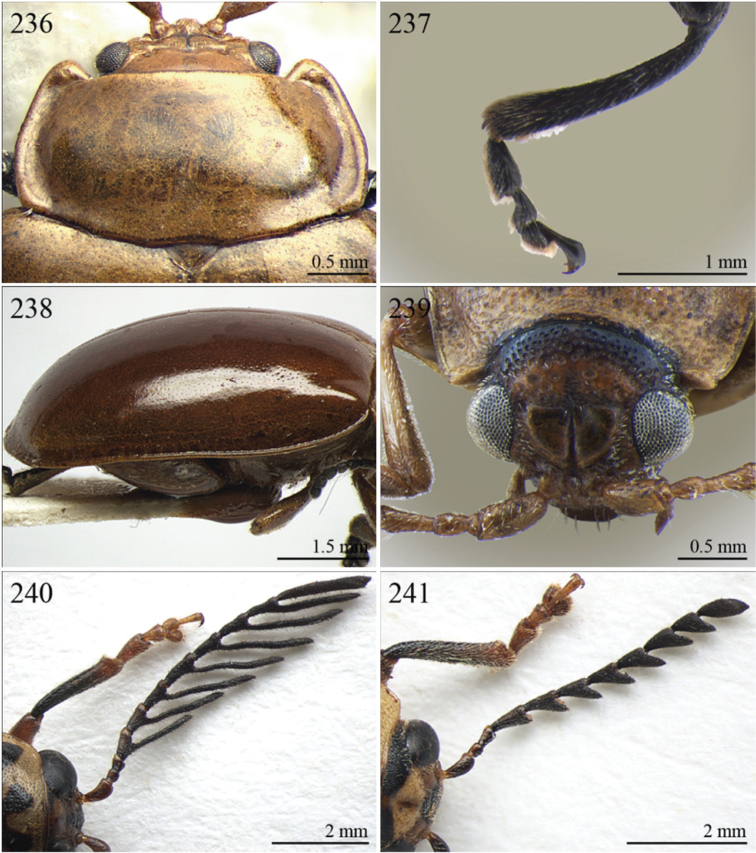
Morphological characters. 236
Physomandroya melanarthra (Fairmaire), head and pronotum in dorsal view 237 Ditto, hind tibia and metatarsus 238
Physomandroya punctulifera Bechyné, elytra in lateral view 239
Physonychis viridipennis (Dalman), head in frontal view 240
Polyclada smythi Bryant, left antenna in male in dorsal view 241 Ditto, left antenna in female in dorsal view.